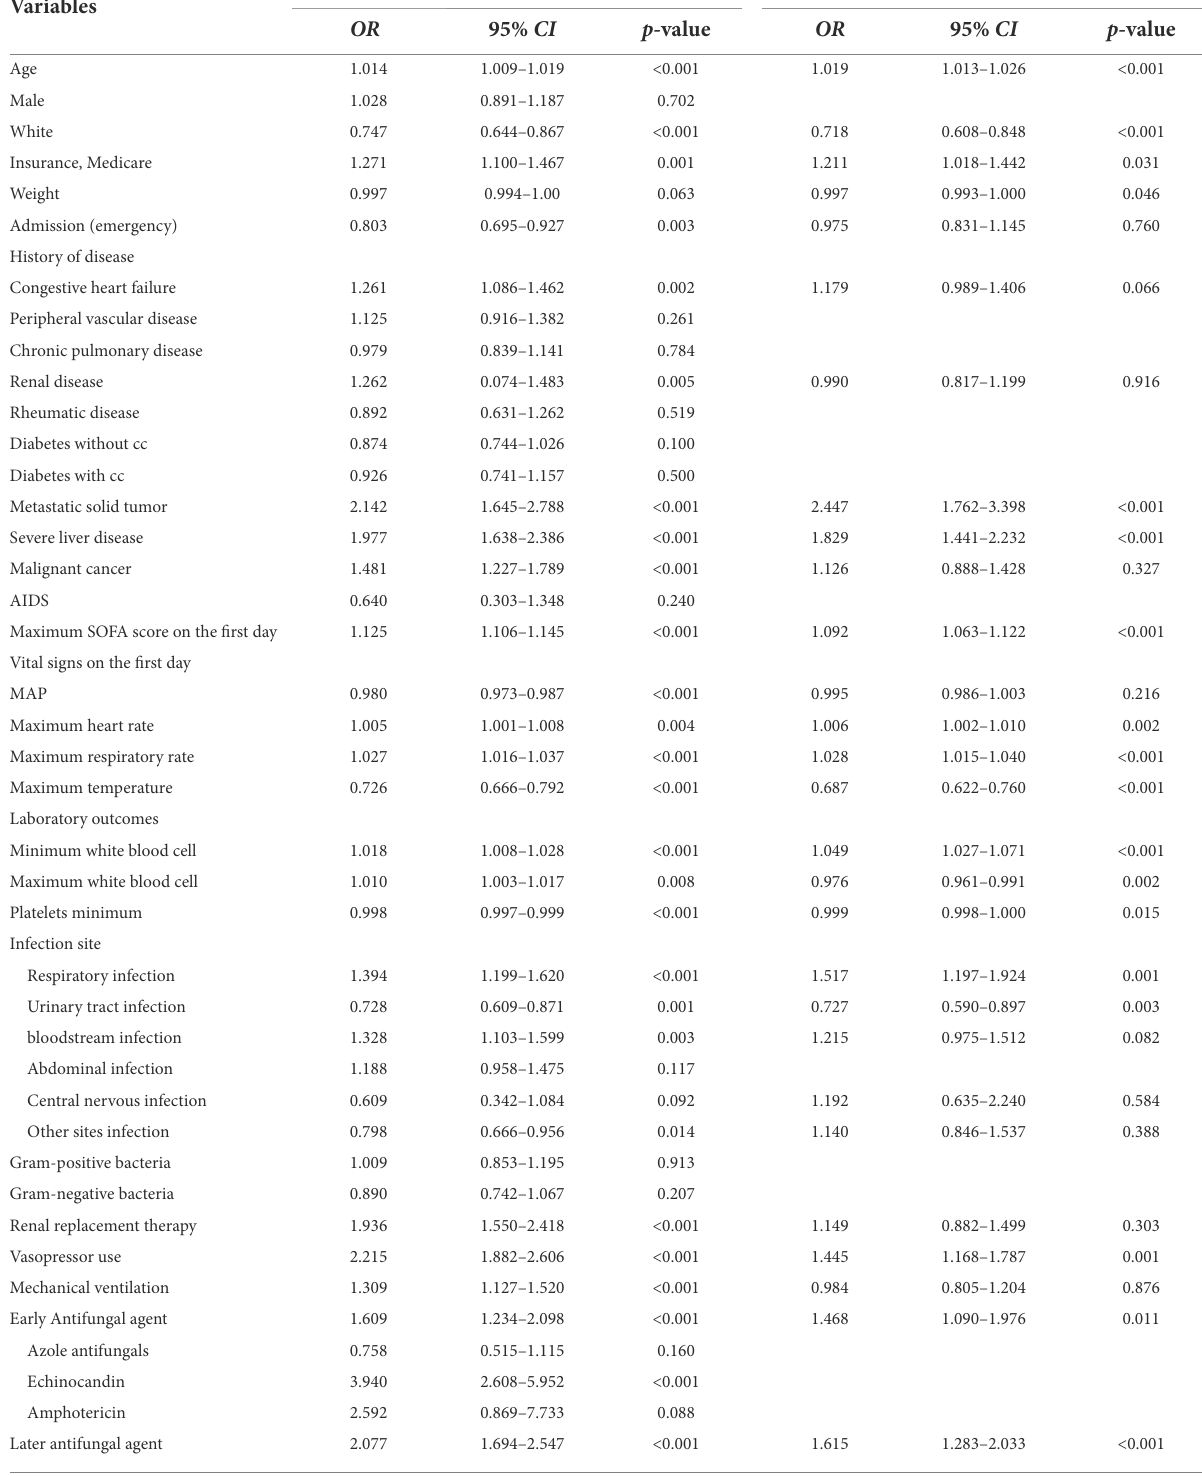
TABLE 4 Risk factors of in-hospital mortality in sepsis patients with positive yeast